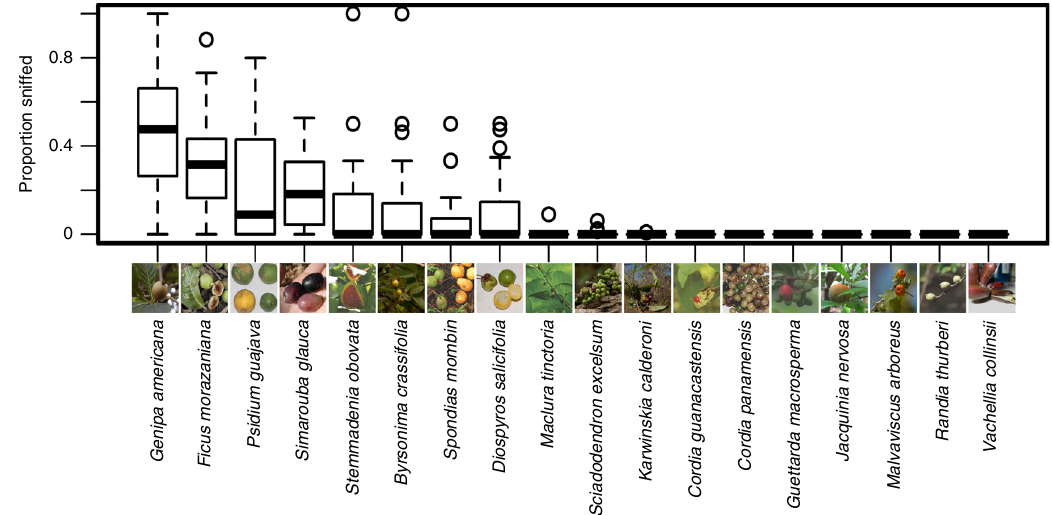
Fig. 1 Variation in fruit snif fi ng behaviour by white-faced capuchins for 18 plant species. Box plots of fruit investigation sequences ( N = 15,160) by individual white-faced capuchin monkeys that included at least 1 snif fi ng event. Medians (bar) are plotted along with upper and lower quartiles (box perimeters), and whiskers stretching to the fi rst data point within 1.5 interquartile ranges of the box. Points beyond the whiskers are plotted as individual symbols. Source data are provided as a Source Data fi le. Photo credit for fruit images: AD Melin